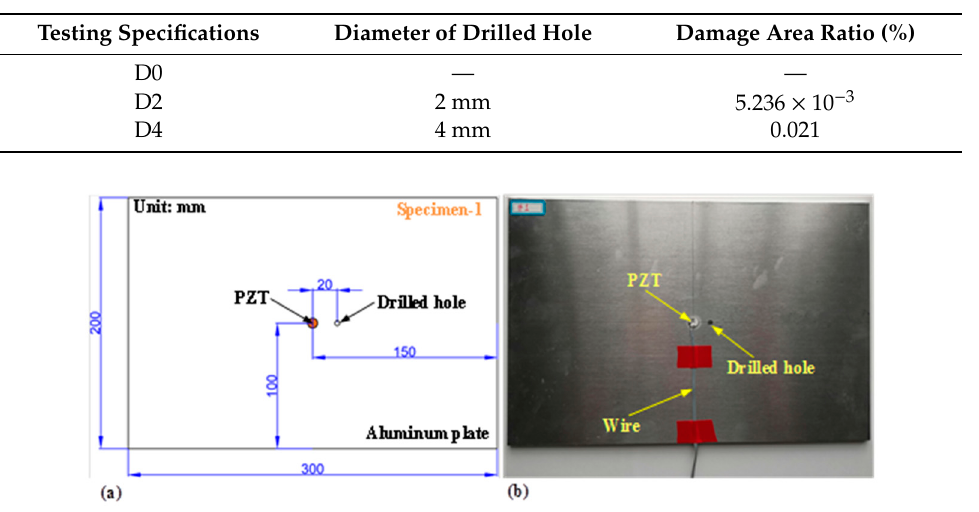
Figure 1. Simulated damage in-situ propagation with increasing hole’s diameter on specimen-1: (a) distribution of the drilled hole, (b) experimentally fabricated specimen. ( a ) distribution of the drilled hole, ( b ) experimentally fabricated specimen.